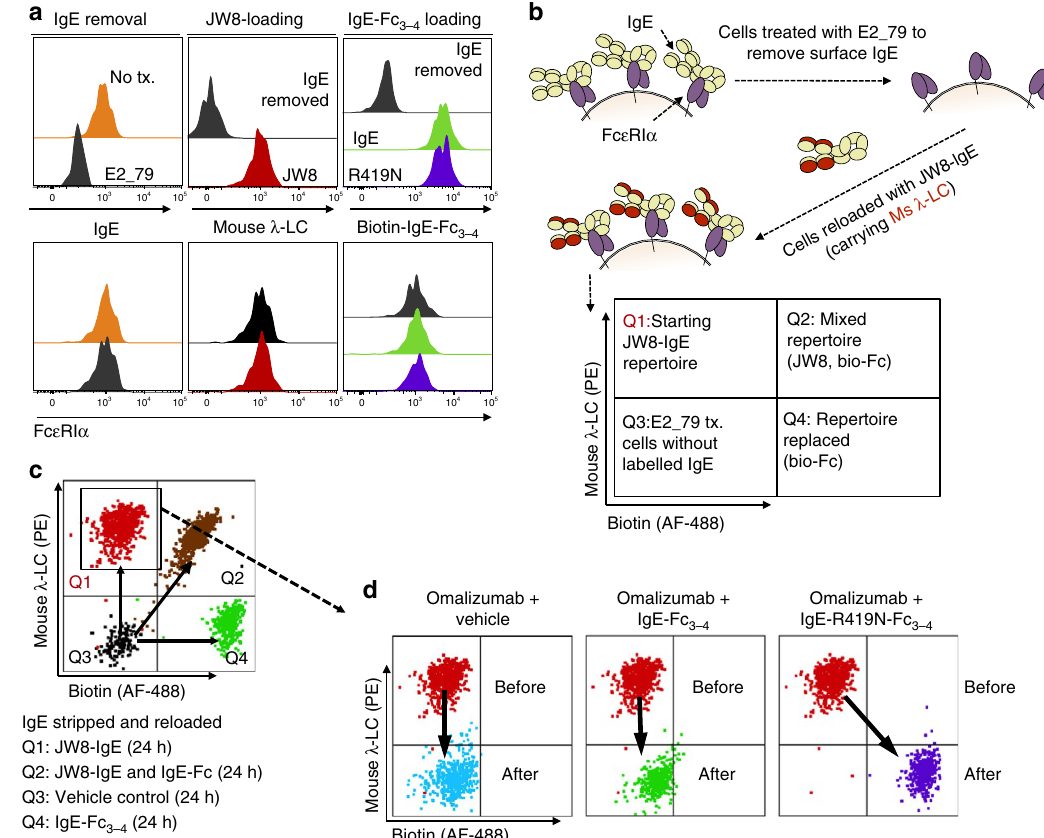
Figure 6 | Exchange of IgE on human basophils. ( a ) Left panel: 2-h treatment with 25 m M E2_79 removes surface IgE from primary human basophils, but does not alter surface Fc e RI a levels within 24h. Middle panel: E2_79-treated basophils can be reloaded with JW8-IgE and tracked by JW8’s mouse- l -light chain ( l -LC). Right panel: biotinylated WT and IgE-R419N-Fc 3–4 variants bind E2_79-treated basophils. ( b ) Experimental design for the IgE exchange. In brief, IgE is removed from primary basophils using E2_79. JW8-IgE is then reloaded on basophils to generate a traceable starting IgE population. ( c ) Experimental validation shows distinct populations of basophils with JW8-IgE (Q1), JW8-IgE and biotinylated IgE-Fc 3–4 (Q2), biotinylated IgE-Fc 3–4 alone (Q4) and E2_79-treated cells without labelled IgE (Q3; displaying merged dot plots from each sample). ( d ) All panels show starting JW8-reloaded population in Q1 before treatment, and cells after treatment. Left panel: overnight treatment with high-concentration omalizumab (25 m M) is sufficient to remove the majority of JW8-IgE. Middle panel: overnight treatment of cells with omalizumab (25 m M) and IgE-Fc 3–4 (1 m gml (cid:3) 1 or B 18nM) results in depletion of JW8-IgE, but no exchange for IgE-Fc 3–4 . Right panel: overnight treatment of cells with omalizumab (25 m M) and IgE-R419N-Fc 3–4 (1 m gml (cid:3) 1 or B 18nM) results in depletion of JW8-IgE, and IgE exchange to IgE-R419N-Fc (cid:3) 1 IgE-Fc doses 3–4 . (Representative dot plots shown. N ¼ 3 at 10 m gml and controls, and N ¼ 3 at 1 m gml (cid:3) 1 IgE-Fc